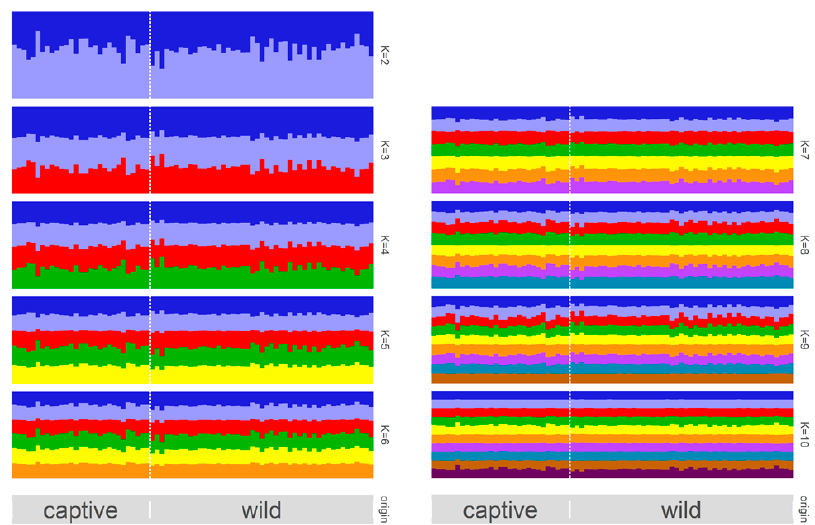
Figure 2. Bayesian analysis of the genetic structure of the populations, showing the differentiation of the captive and wild populations of the Tsushima leopard cat based on 139 SNPs. This figure was obtained using Pophelper to align the 10 replicates for optimal K = 21–10 (All runs were performed using the Markov chain Monte Carlo method running for 500,000 samples and using an initial burn-in of 300,000 samples).